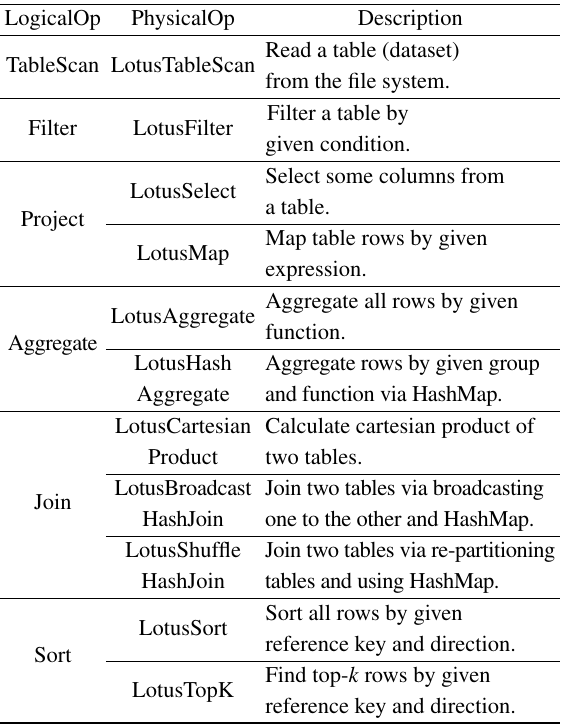
Table 1 Operator